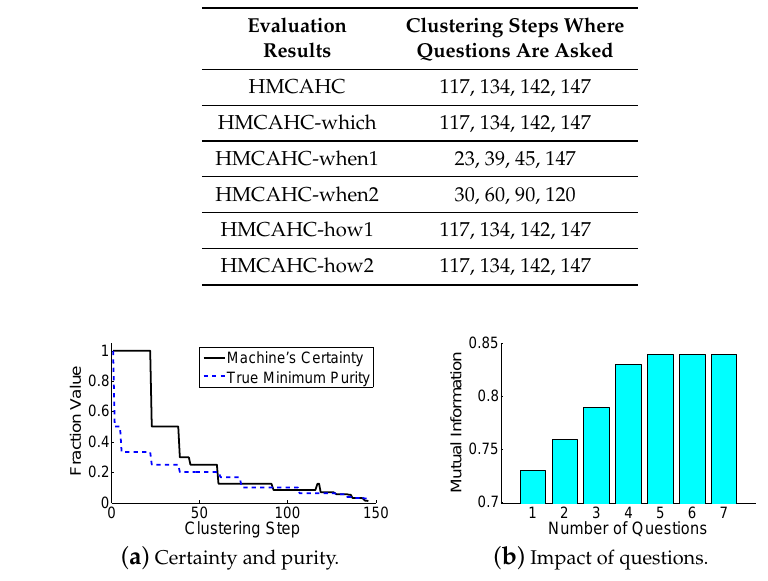
Figure 7. Evaluation results for the Iris Flower Data